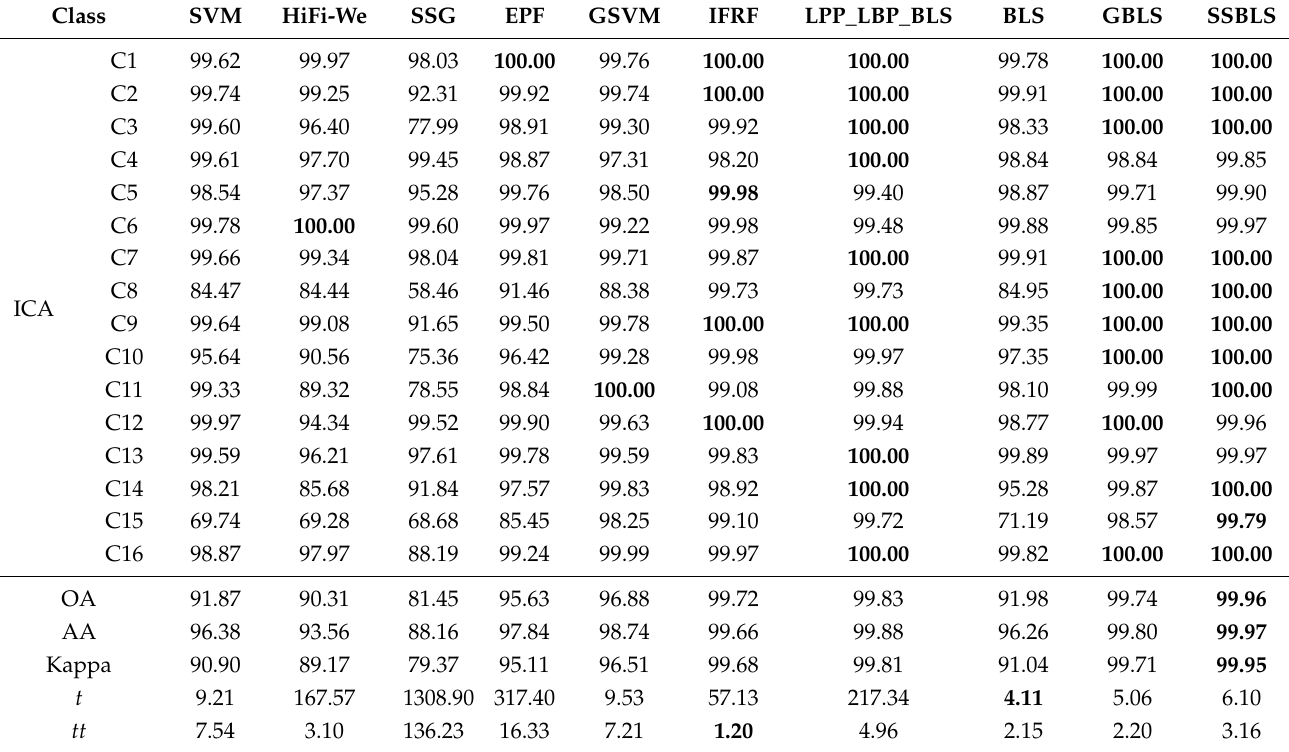
Table 4. Classification results of all comparison methods on the Salinas dataset in term of individual classification